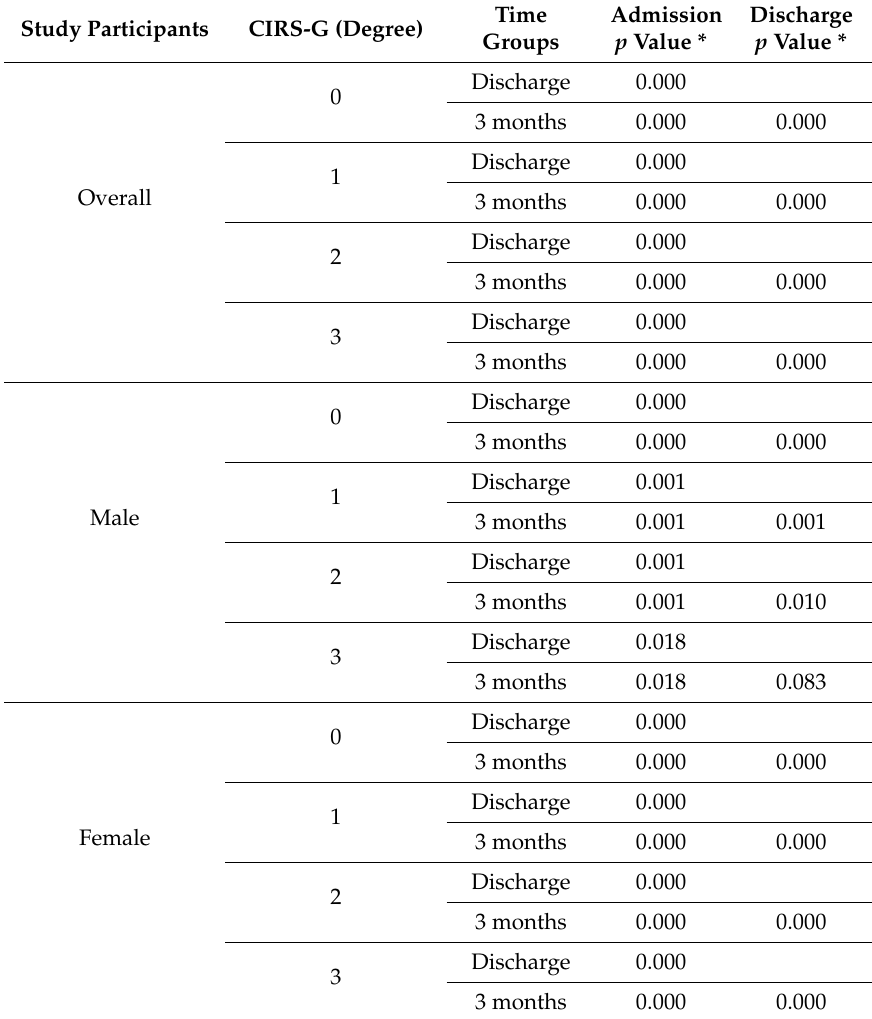
Table 4. Correlations of SF-36 PFC values in defined severity degree of CIRS-G regarding the time of